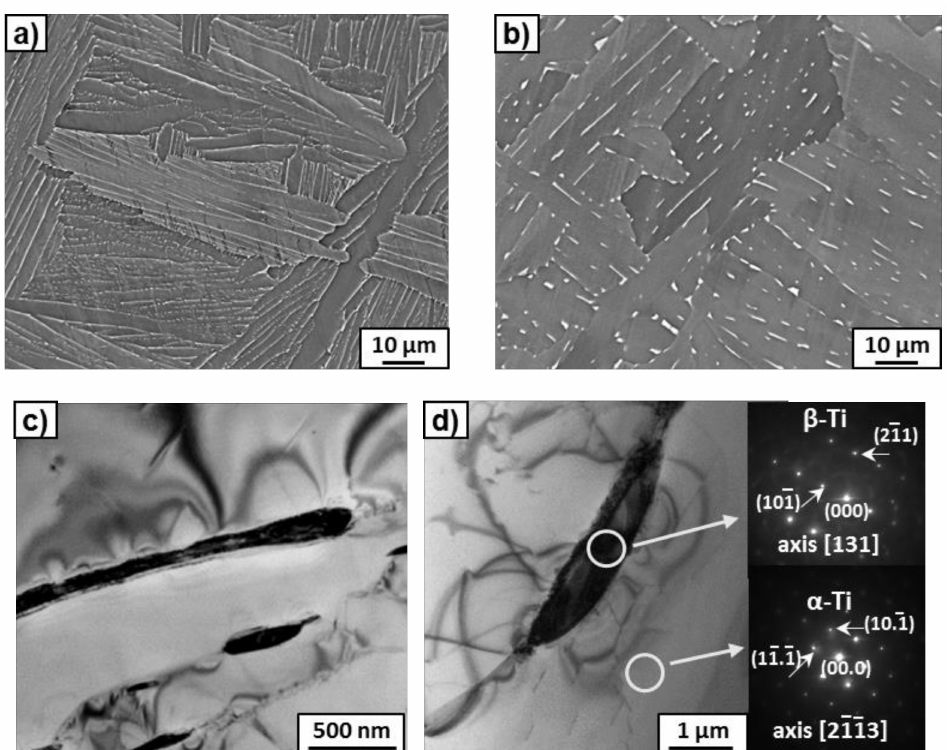
Figure 1. ( a , b ) SEM and ( c , d ) TEM micrographs of the Ti–3wt.% Nb alloy annealed at 450 ◦ C ( a , c ) and 600 ◦ C ( b , d ). Bright-field images ( c , d ) with SAED patterns indicated the β - and α -phases. The white circles marked in the image ( d ) show the areas from which SAED patterns were